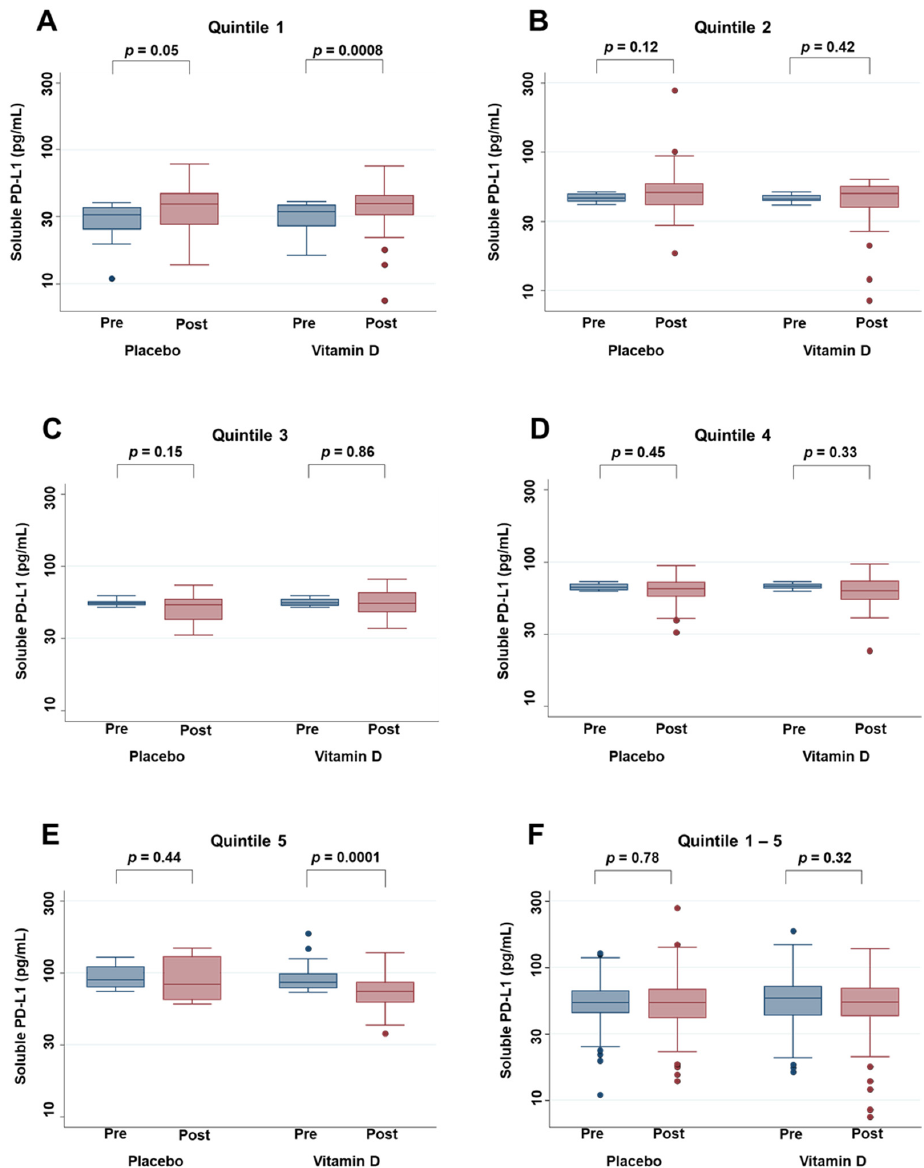
Figure 3. Box plot of changes in serum PD-L1 levels in the placebo group and the vitamin D group compared ( A ) for the subgroup of 1st quintile of PD-L1 levels (Quintile 1), ( B ) for the subgroup of 2nd quintile of PD-L1 levels (Quintile 2), ( C ) for the subgroup of 3rd quintile of PD-L1 levels (Quintile 3), ( D ) for subgroup of 4th quintile of PD-L1 levels (Quintile 4), ( E ) for subgroup of 5th quintile of PD-L1 levels (Quintile 5), ( F ) Sum of 1st – 5th quintiles of PD-L1 levels. Pre = after the surgery and just before starting supplements; Post = 1 year after starting supplementation. Changes between pre and post were evaluated with the Wilcoxon signed-rank test.